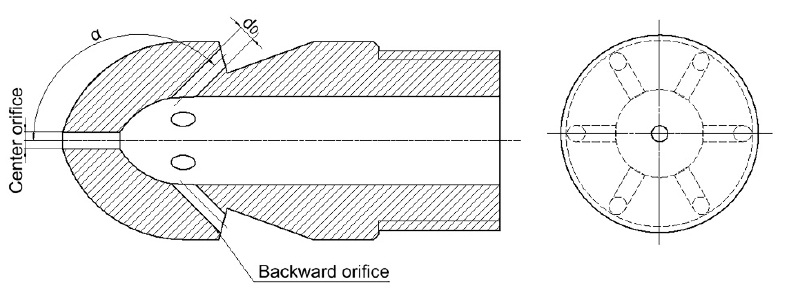
Figure 4. Schematic of multi-orifice nozzle #19 (0 + 1 + 6).